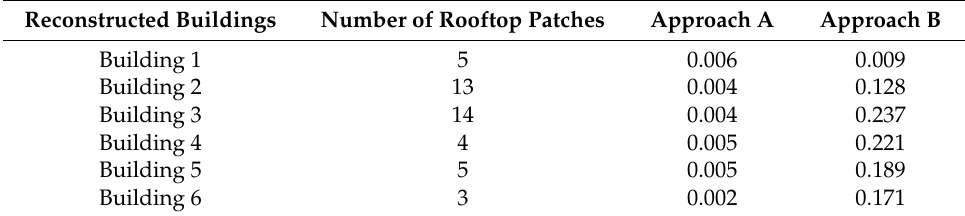
Figure 14. Roughness comparison between Approaches A and B: ( a ), ( c ) roughness of roof models reconstructed using Approach A for Buildings 4 and 6; ( b ), ( d ) roughness of roof models reconstructed using Approach B for Buildings 4 and 6, respectively. Data are represented by points with different colors. Table 7. Roughness comparison of building roof models for Approaches A and